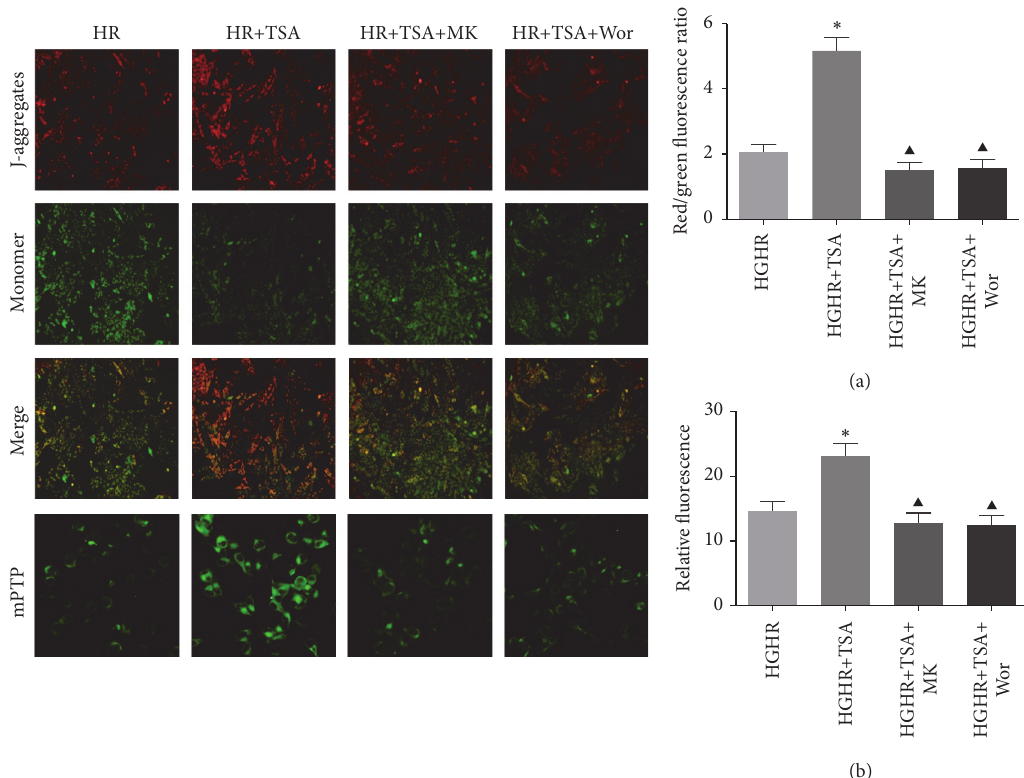
Figure 8: Effect of HDAC inhibition on mitochondrial membrane potential and integrity of mitochondrial permeability transition pore (mPTP). Representative fluorescent images and quantitative analysis in each group. (a) Red fluorescence represented JC-1 aggregation on the mitochondria membrane, reflecting the mitochondrial membrane potential ( ΔΨ𝑚 ). Green emission of the dye represented the monomeric form of JC-1 after mitochondrial membrane depolarization. (b) Fluorescent images of the cells show the change in integrity of mPTP. Reduced fluorescence in cells indicate opening of mPTP. All values are presented as the mean ± SEM, 𝑛 = 6 /group. ∗ 𝑝 < 0.05 versus HGHR group. 󳵳 𝑝 < 0.05 versus HGHR+TSA